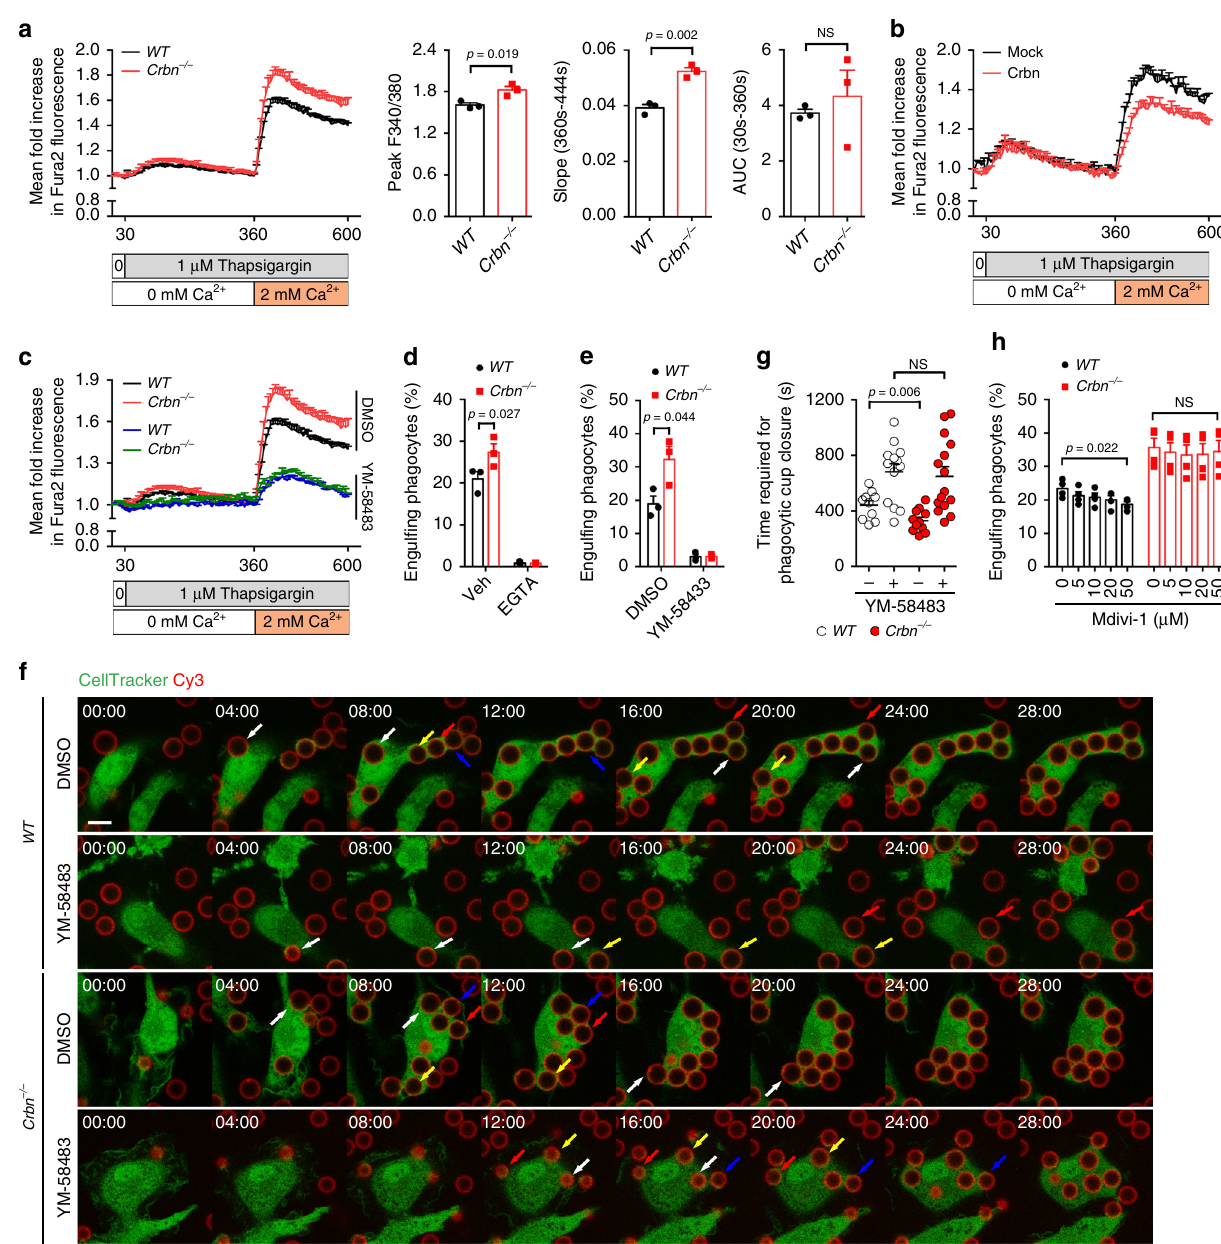
Fig. 3 Crbn modulates SOCE mediated by CRAC channels. a , b BMDMs from the indicated mice a or Crbn-overexpressing LR73 cells b were stained with Fura2-AM and then treated with 1 µ M thapsigargin for the indicated duration. Thereafter, 2 mM calcium was added to the cells at the indicated time. Fluorescence of the cells was measured with a microplate reader. AUC area under curve. n = 3 experiments, mean ± SEM. NS not signi fi cant (two-tailed unpaired Student t test). c BMDMs derived from WT or Crbn − / − mice were pre-incubated with 10 µ M YM-58483 and then SOCE was measured as in a . d , e BMDMs derived from WT or Crbn − / − mice were incubated with TAMRA-stained apoptotic cells in 5 mM EGTA d or 10 μ M YM-58483 e . Thereafter, engul fi ng phagocytes were analyzed by fl ow cytometry. n = 3 experiments, mean ± SEM (two-tailed unpaired Student t test). f , g BMDMs derived from WT and Crbn − / − mice were incubated with Cy3-labeled PS beads and observed using time-lapse confocal microscopy f . Time required for phagocytic cup closure was measured g . Arrows with a same color indicate a same PS bead being engulfed. Scale bar, 10 µ m. n = 3 experiments (each dot represents one PS bead), mean ± SEM. NS not signi fi cant (two-way ANOVA). h BMDMs from indicated mice were incubated with TAMRA-stained apoptotic cells in the indicated concentration of Mdivi-1, and engul fi ng phagocytes were analyzed by fl ow cytometry. n = 4 experiments, mean ± SEM. NS not signi fi cant (one- way